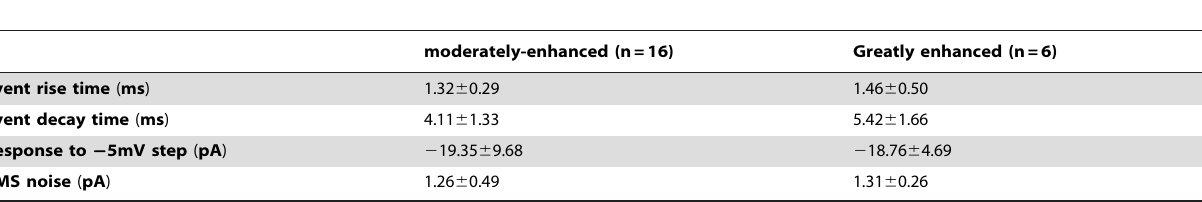
Table 1. Neurons from the greatly-enhanced and the moderately-enhanced trained groups did not significantly differ in their membrane properties and recording